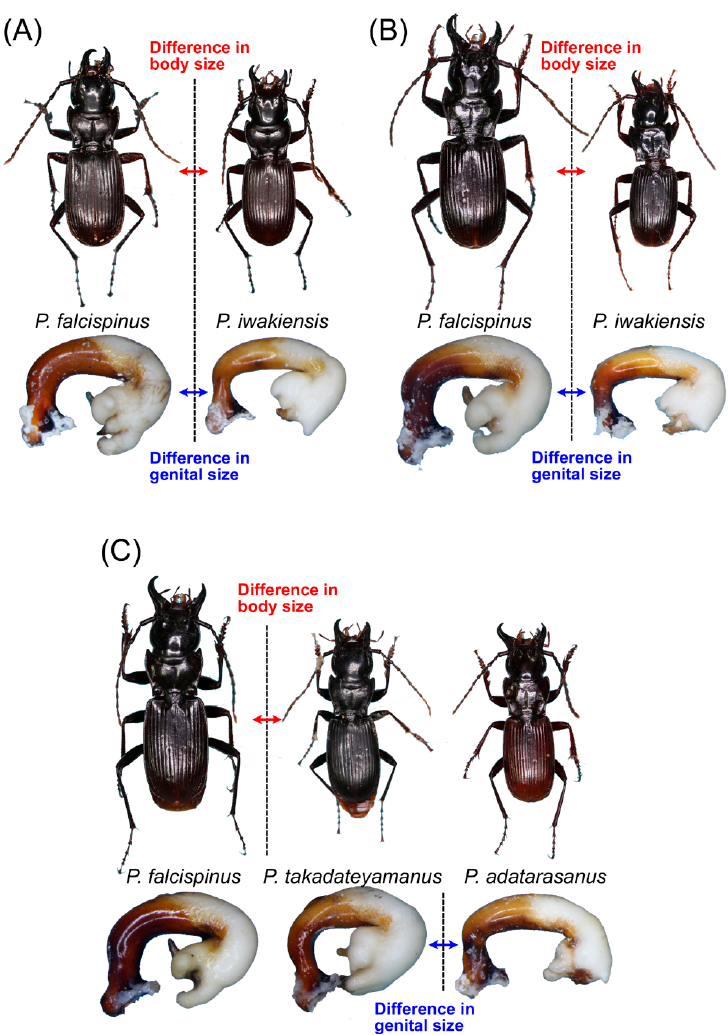
Figure 8. Body size and male genitalia size differences among sympatric species at Miyahisa ( A ), Nukumidaira ( B ), and Mt. Takadateyama ( C ).